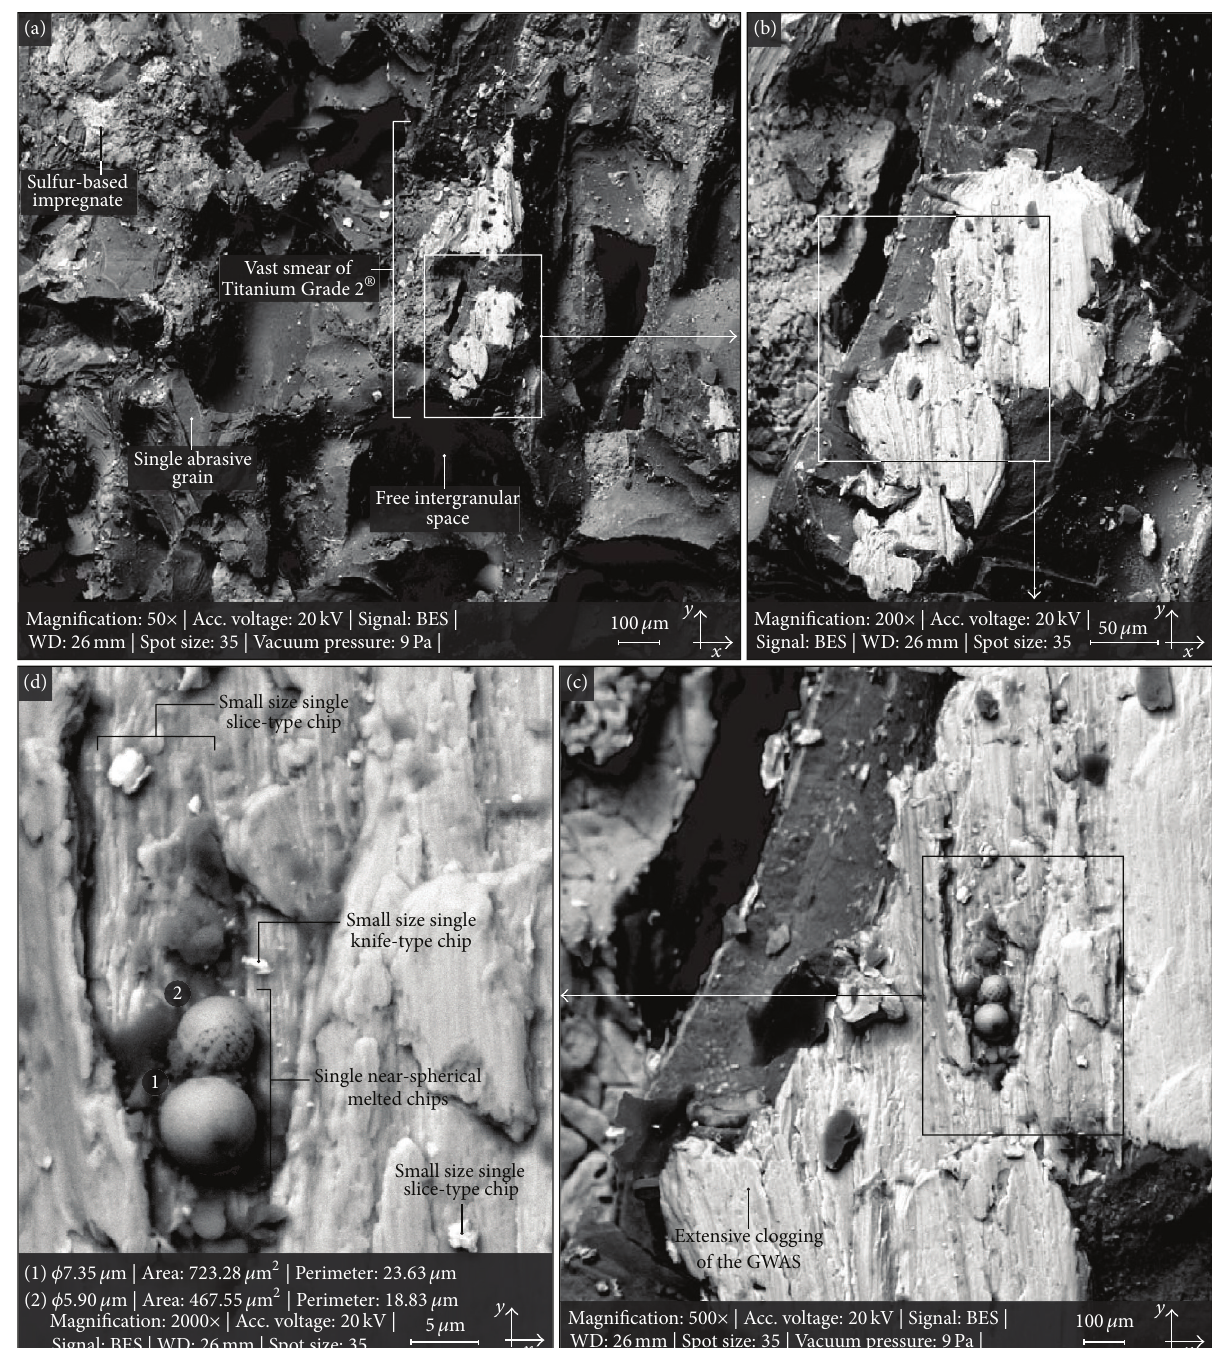
Figure 3: General morphology of near-spherical melted chips formed after internal cylindrical plunge grinding of Titanium Grade 2 alloy obtained by use of scanning electron microscope JSM-550LV produced by JEOL: (a) SEM micrograph (size: 1785 × 1586.66 𝜇 m, mag. 50 × ) of GWAS 1–35 × 20 × 10-SG/F46K7VTO impregnated by sulphur with two vast clogged areas, (b) AOI (size: 400 × 288.33 𝜇 m, mag. 200 × ) extracted from (a), (c) AOI (size: 181.50 × 171.00 𝜇 m, mag. 500 × ) extracted from (b) with couple of clearly visible single near-spherical melted chips in central part of image, and (d) AOI (size: 80.78 × 58.23 𝜇 m, mag. 2000 × ) extracted from (c) with calculated basic dimensions of chips. Note: Acc. voltage, accelerating voltage; BES, backscattered electron (shadow image); WD, working